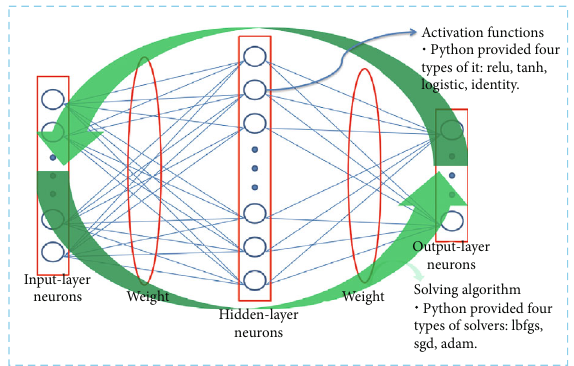
Figure 2: Basic principles and structure of the multilayer perceptron networks implemented in